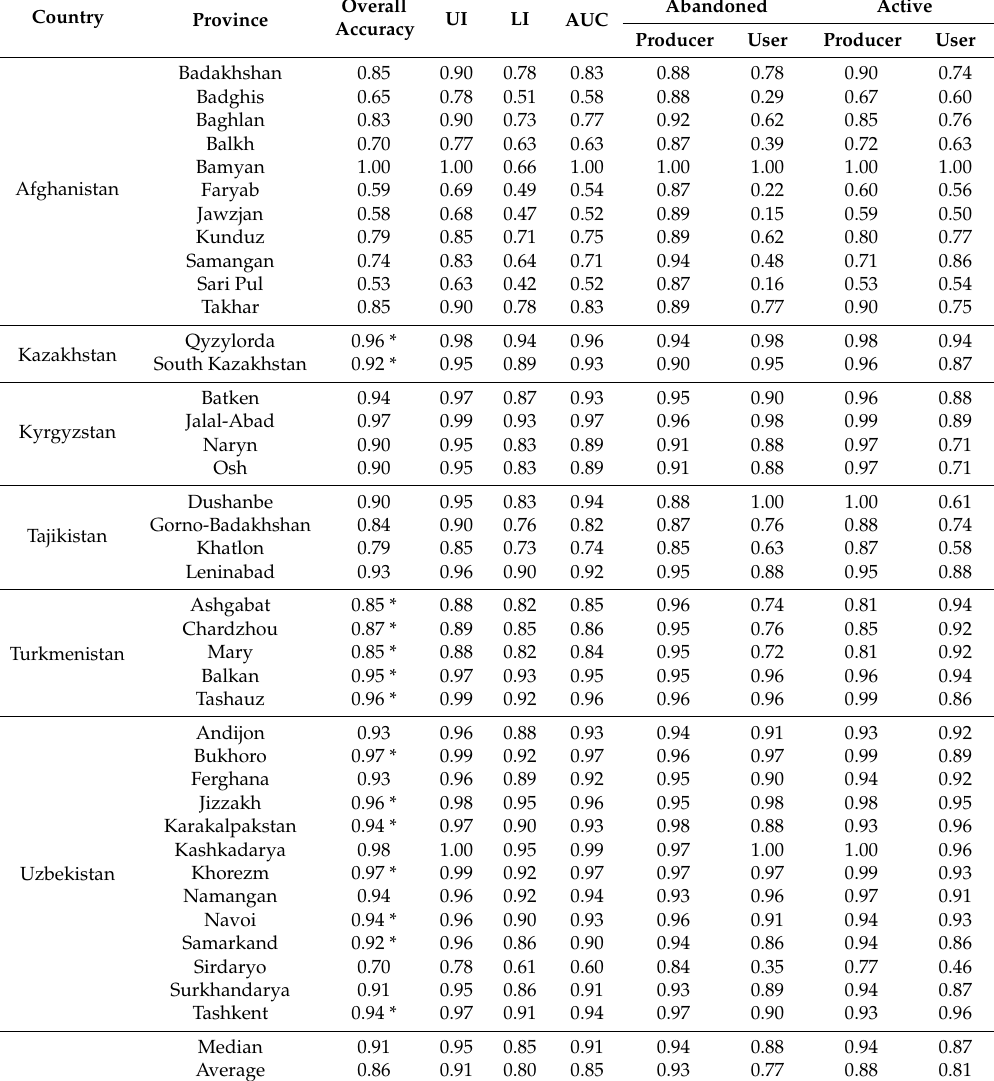
Table 4. Overall, producer’s and user’s accuracies of abandoned and active cropland across 39 administrative level-II regions (provinces) in six countries of the Aral Sea Basin, based on the stratified classifier